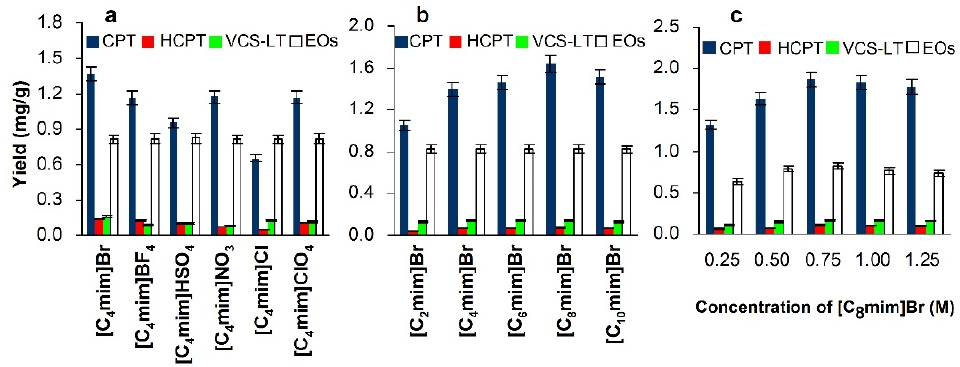
Figure 4. Effects of IL anions ( a ) and cations ( b ) and concentration of [C 8 mim] Br ( c ) on yields of CPT, HCPT, VCS-LT, and EOs.